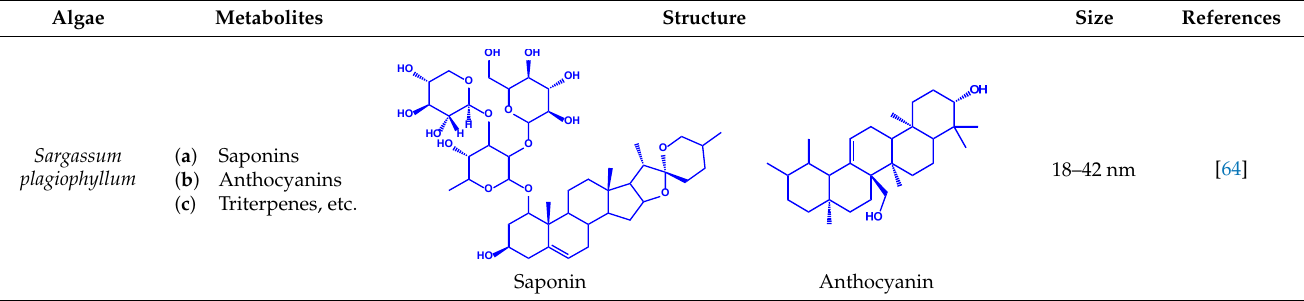
Table 3. Biological synthesis of AgNPs by various strains of algae and fungi.